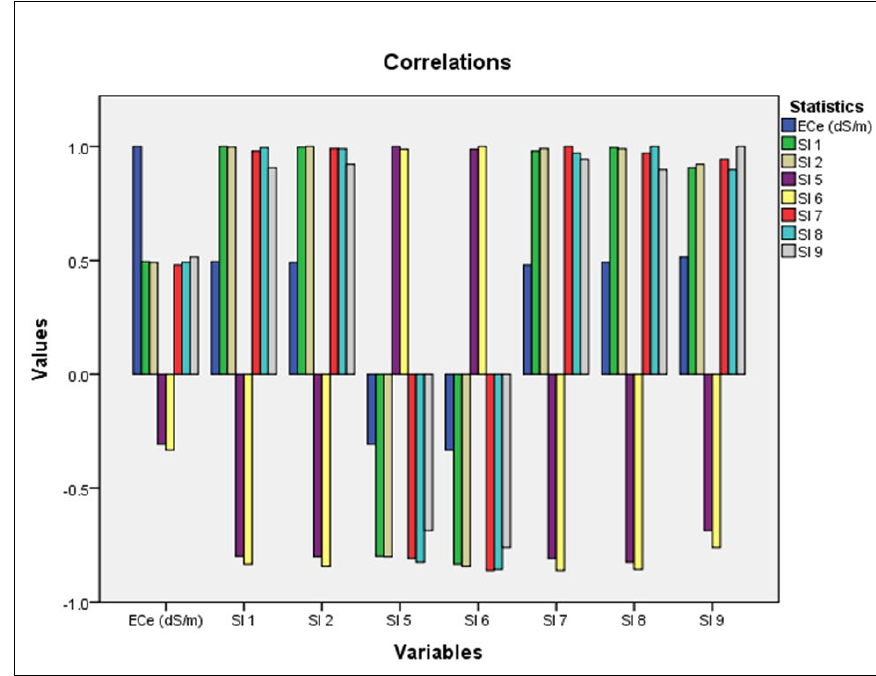
Figure 6. Pearson correlation among soil salinity indices and soil EC e .